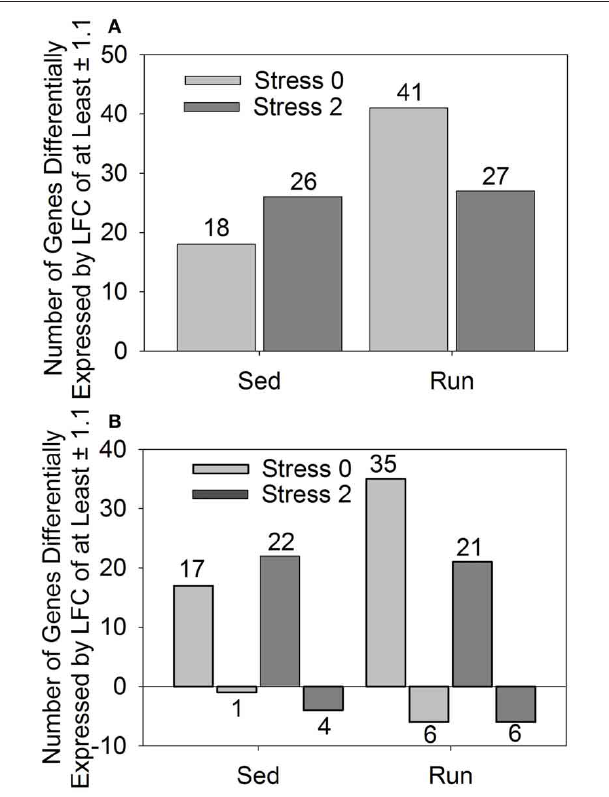
FIGURE 1 | Number of genes differentially expressed by a log fold change ≥ ± 1 . 1 in rats exposed to stress compared to home cage non-stressed controls. (A) Total number of genes differentially expressed and (B) Number of genes differentially upregulated or